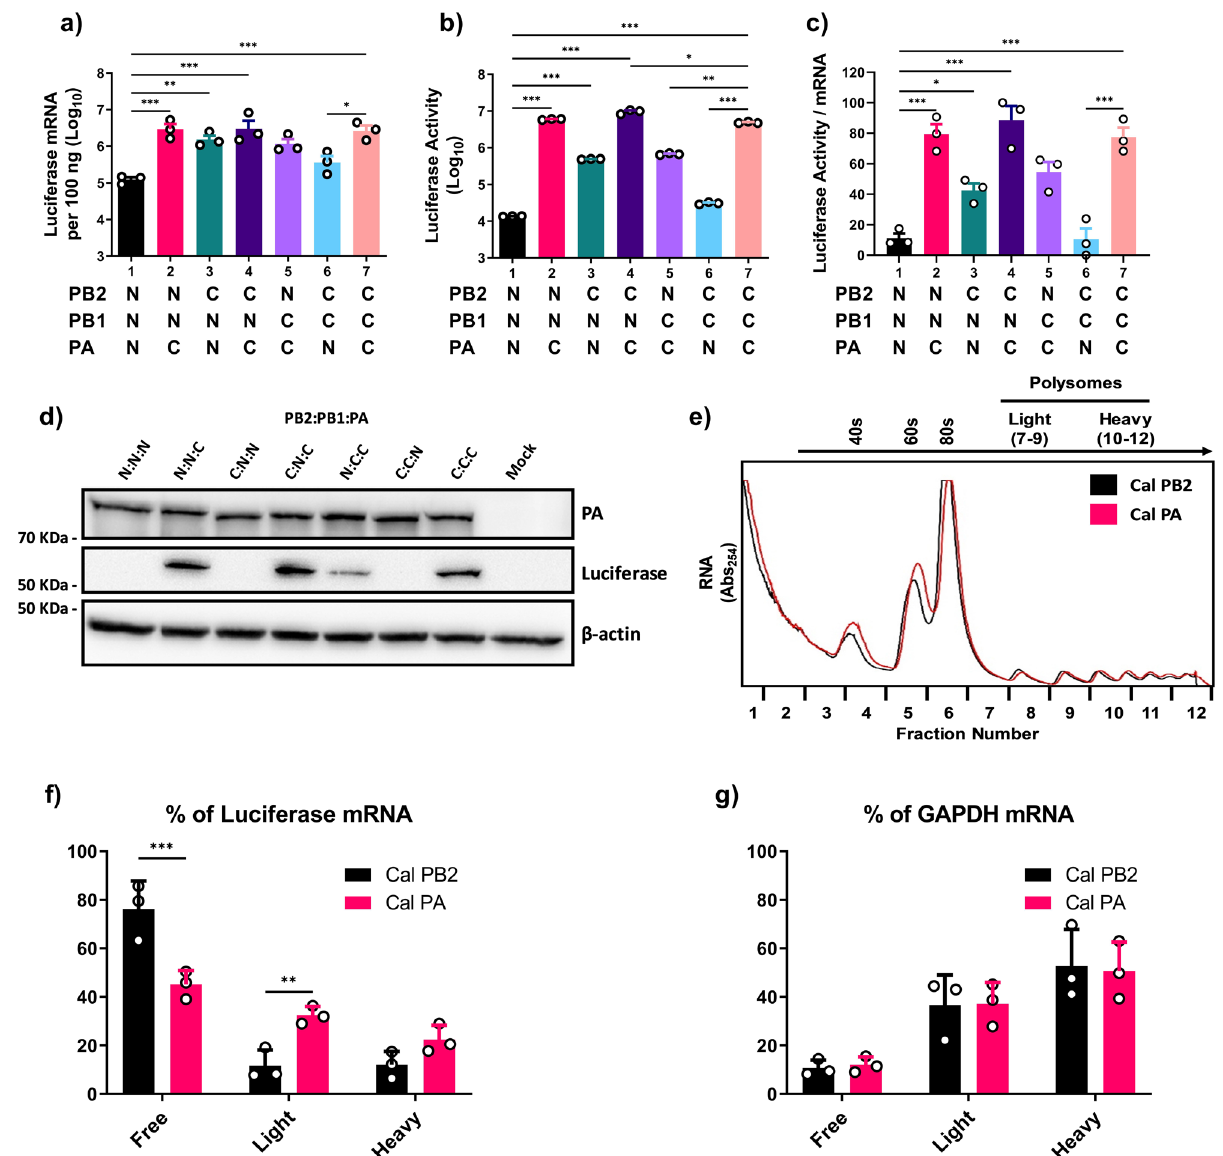
Fig. 1 Origin of vRdRp components determines the translation ef fi ciency of viral mRNA. 293 T cells were transfected with the indicated viral polymerase subunits (N = Nan, C = Cal) along with pPolI-NP-luc. Cal NP was used in all conditions. a Luciferase mRNA from the pPolI-NP-luc construct was quanti fi ed by qRT-PCR. b Luciferase activity determined by the Dual-Luciferase Reporter Assay system (Promega). c Ratio of luciferase activity per mRNA, transformed to a normal distribution. d Representative image of immunoblot analysis of PA, luciferase and β -actin in cell lysates using speci fi c antibodies. e – g 293 T cells were transfected with either Nan NP, PB1, PB2 and Cal PA or Nan NP, PB1, PA, and Cal PB2 along with pPolI NP-luc. e Representative polysome traces for the two conditions are overlaid with one another. f , g mRNA from pPolI-NP-luc and cellular GAPDH was quanti fi ed from each fraction by qRT-PCR and grouped into polysome free (fractions 1 – 6), light (fractions 7 – 9) or heavy (fractions 10 – 12). All error bars show means plus/minus the standard deviations ( n = 3 biological replicates). One-way ANOVA followed by Tukey ’ s multiple comparison test (* P < 0.05, ** P < 0.01, *** P <